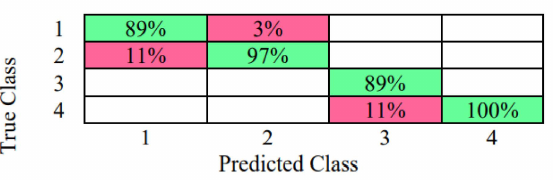
Figure 5. Positive–negative predictive values of linear SVM confusion matrix of Raw data, (Green refers to True Positive, red refers to False negative).